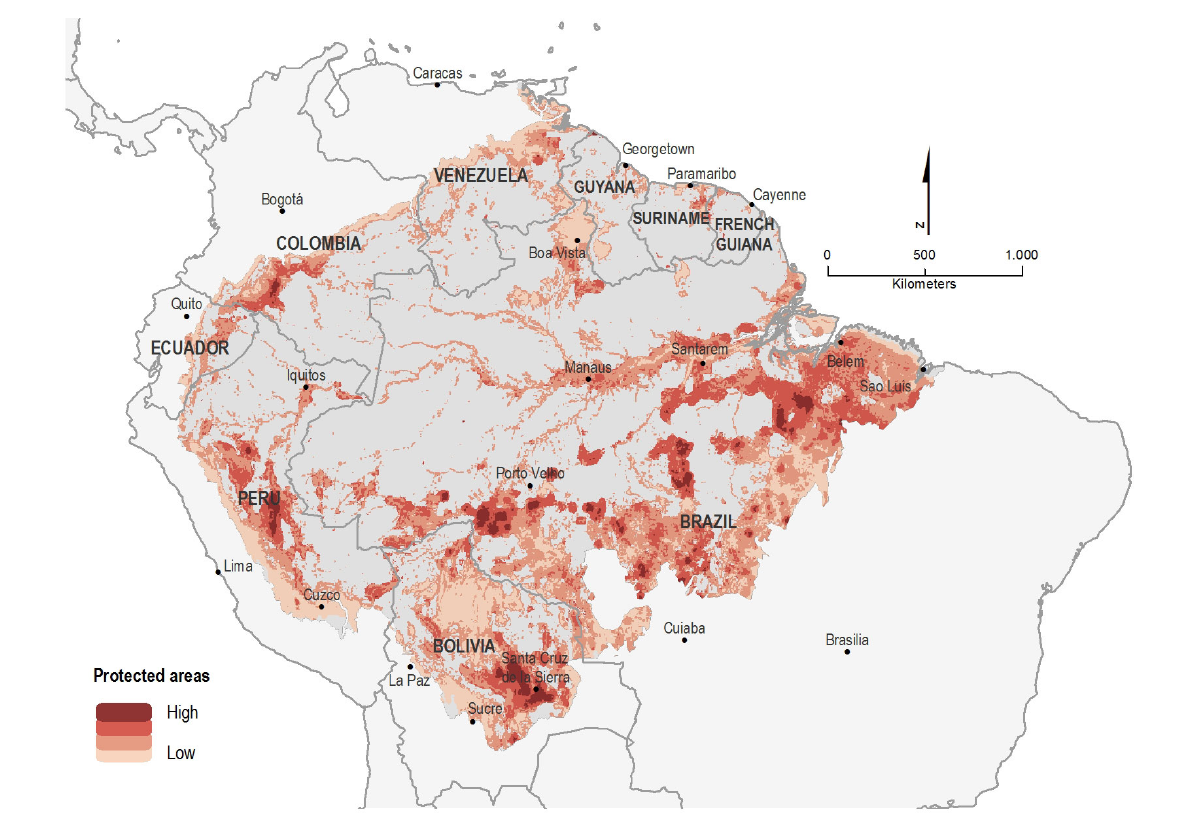
Fig. 5 . Vulnerability to deforestation based on recent deforestation projections from 2010 to 2014. Values range